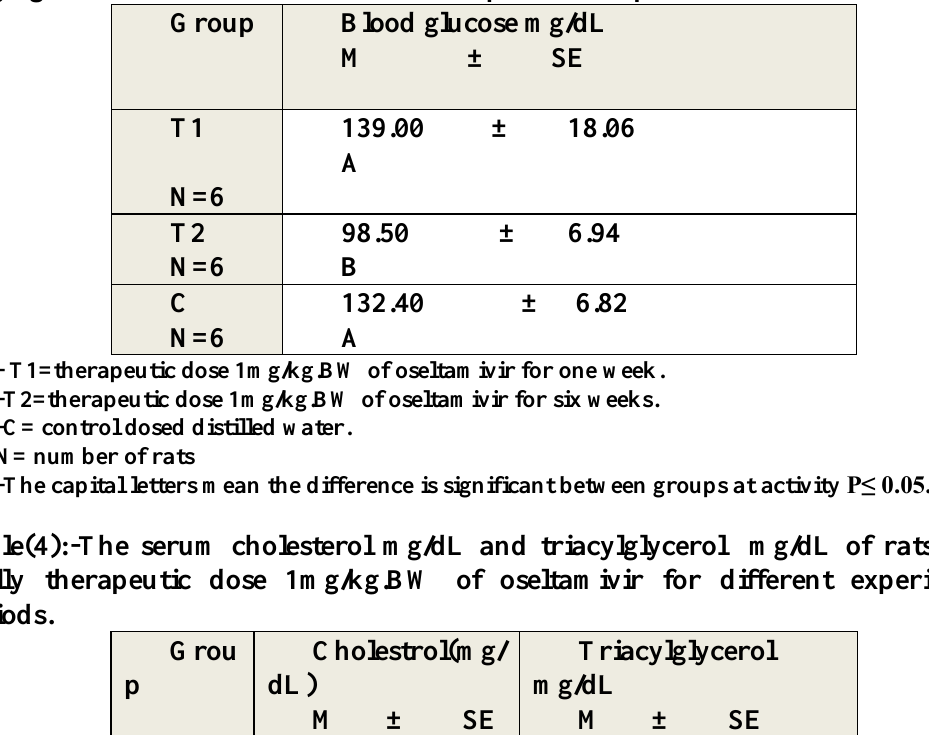
Table(3):- Random blood sugar mg/dL of rats dosed orally therapeutic dose 1mg/kg.BW of oseltamivir for different experimental periods .